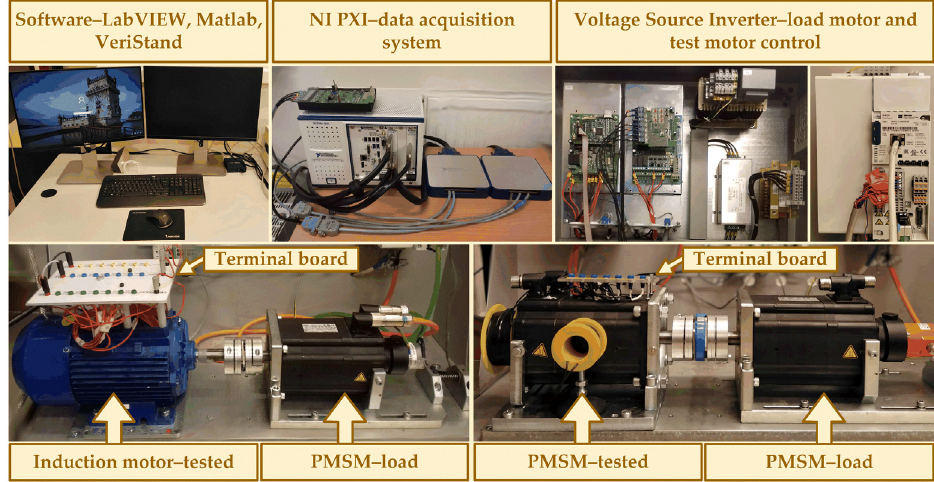
Figure 4. Experimental setup—laboratory stands with IM (Table A1) and PMSM (Table